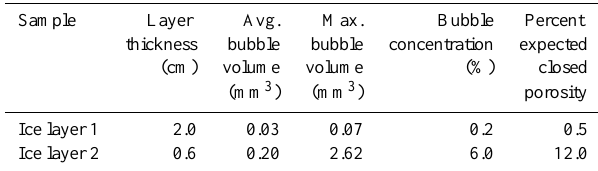
Figure 2. The density profiles near (a) ice layer 1, and (b) ice layer 2, where the closed diamonds indicate normal firn core samples and the open diamonds indicate the core sample containing the ice layer, with error bars indicating measurement error of 0.5%. The black line is the densification rate found from the density measurements, and the gray lines indicate the upper and lower bounds of the 95% prediction interval, calculated based on the densification rate. Table 1. Microstructural parameters of ice layer